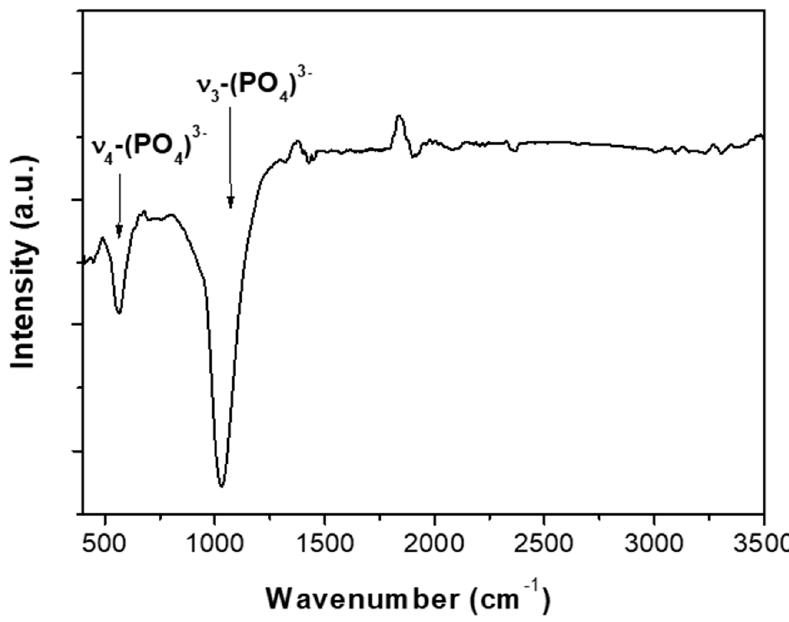
Figure 6. Fourier transform infrared (FTIR) spectrum of the HA coating. Table 1. Atomic chemical composition percentages of the HA surface.